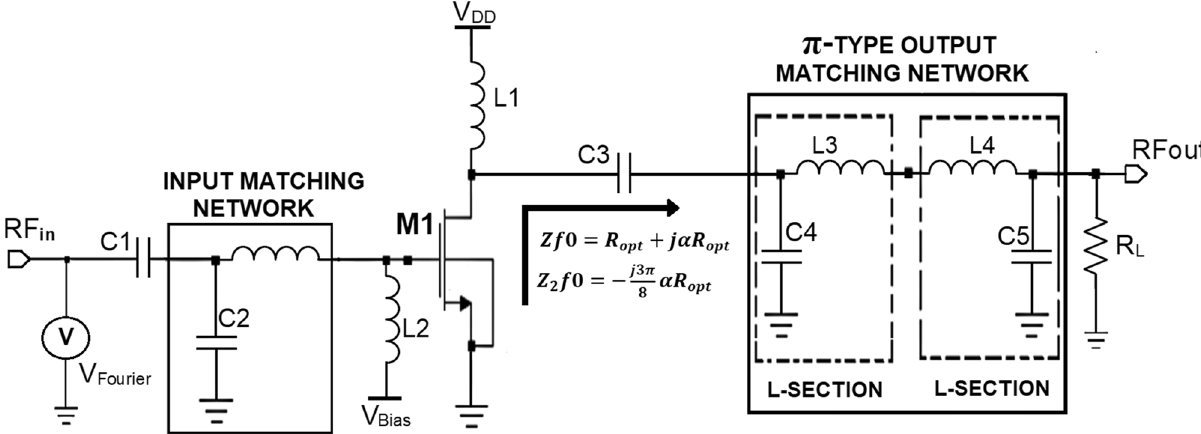
Figure 4. Sample Class-J mode PA topology with π - matching